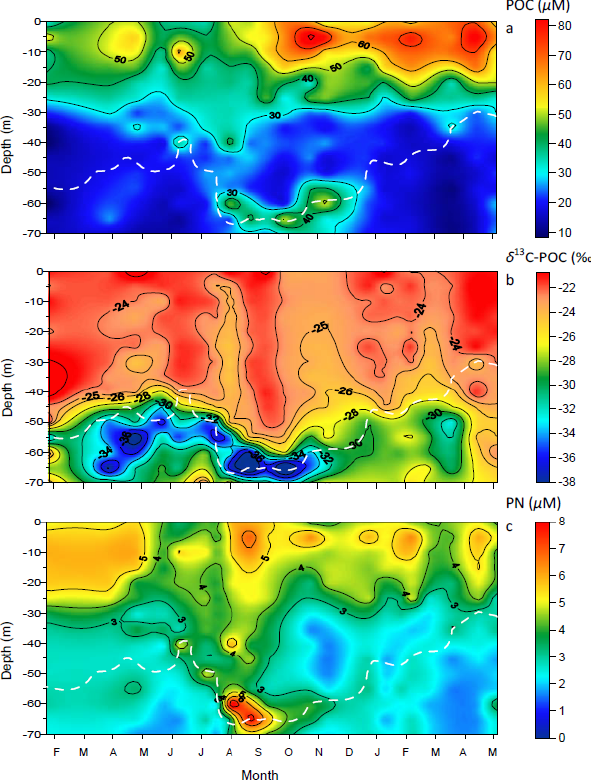
Figure 4. Temporal variability of (a) the particulate organic car- bon (POC) concentration (µmolL − 1 ) , (b) the δ 13 C signature of the POC pool, and (c) the particulate nitrogen (PN) concentration (µmolL − 1 ) in the mixolimnion of Lake Kivu, between February 2012 and May